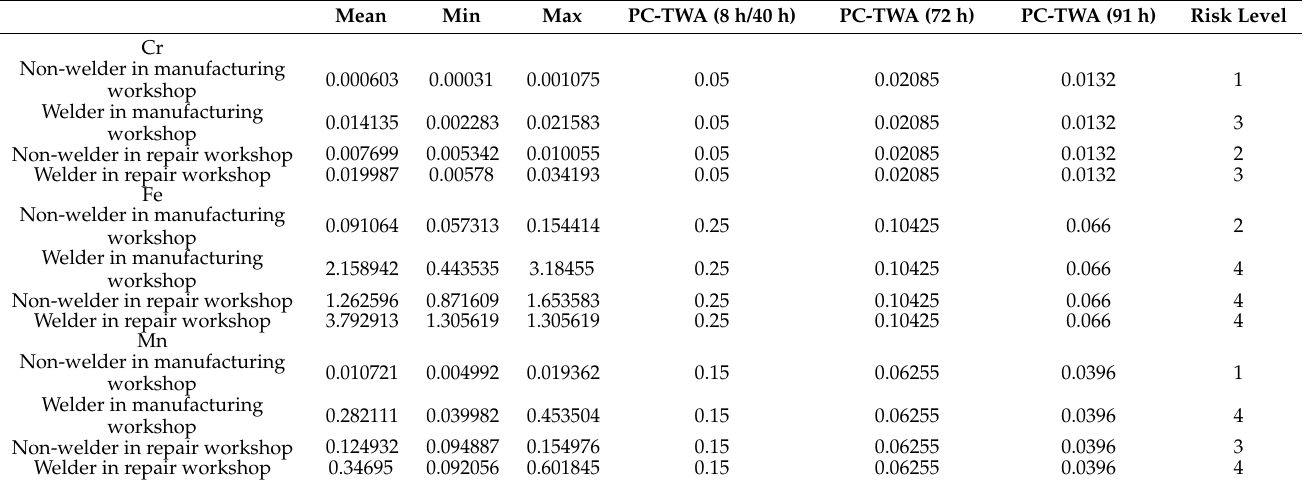
Table 2. Exposure levels to heavy metals in the work environment (mg/m 3